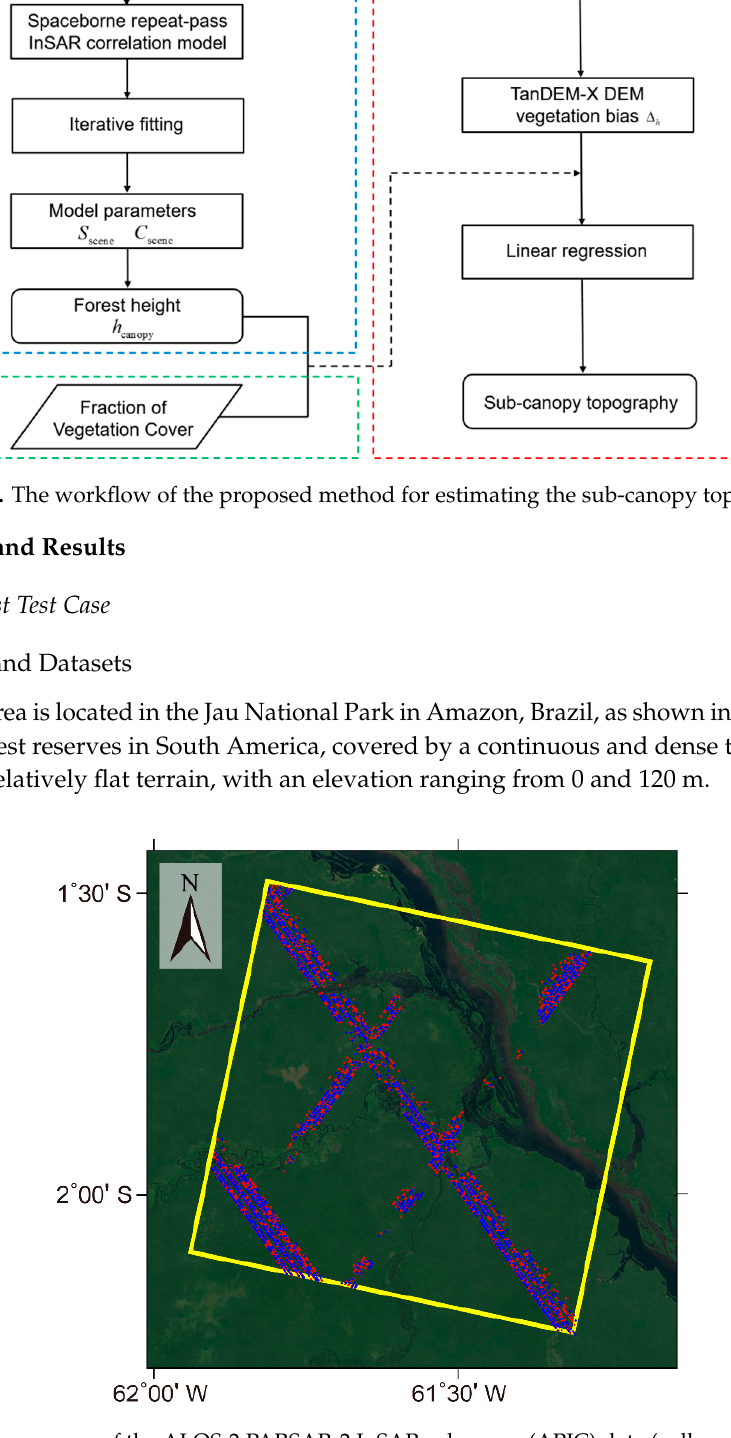
Figure 3. The coverage of the ALOS-2 PARSAR-2 InSAR coherence (APIC) data (yellow rectangle) and the spatial distribution of the GEDI observations (the blue and red points represent the training sample and validation data, respectively) over this study area. The background image was downloaded from Google Earth.